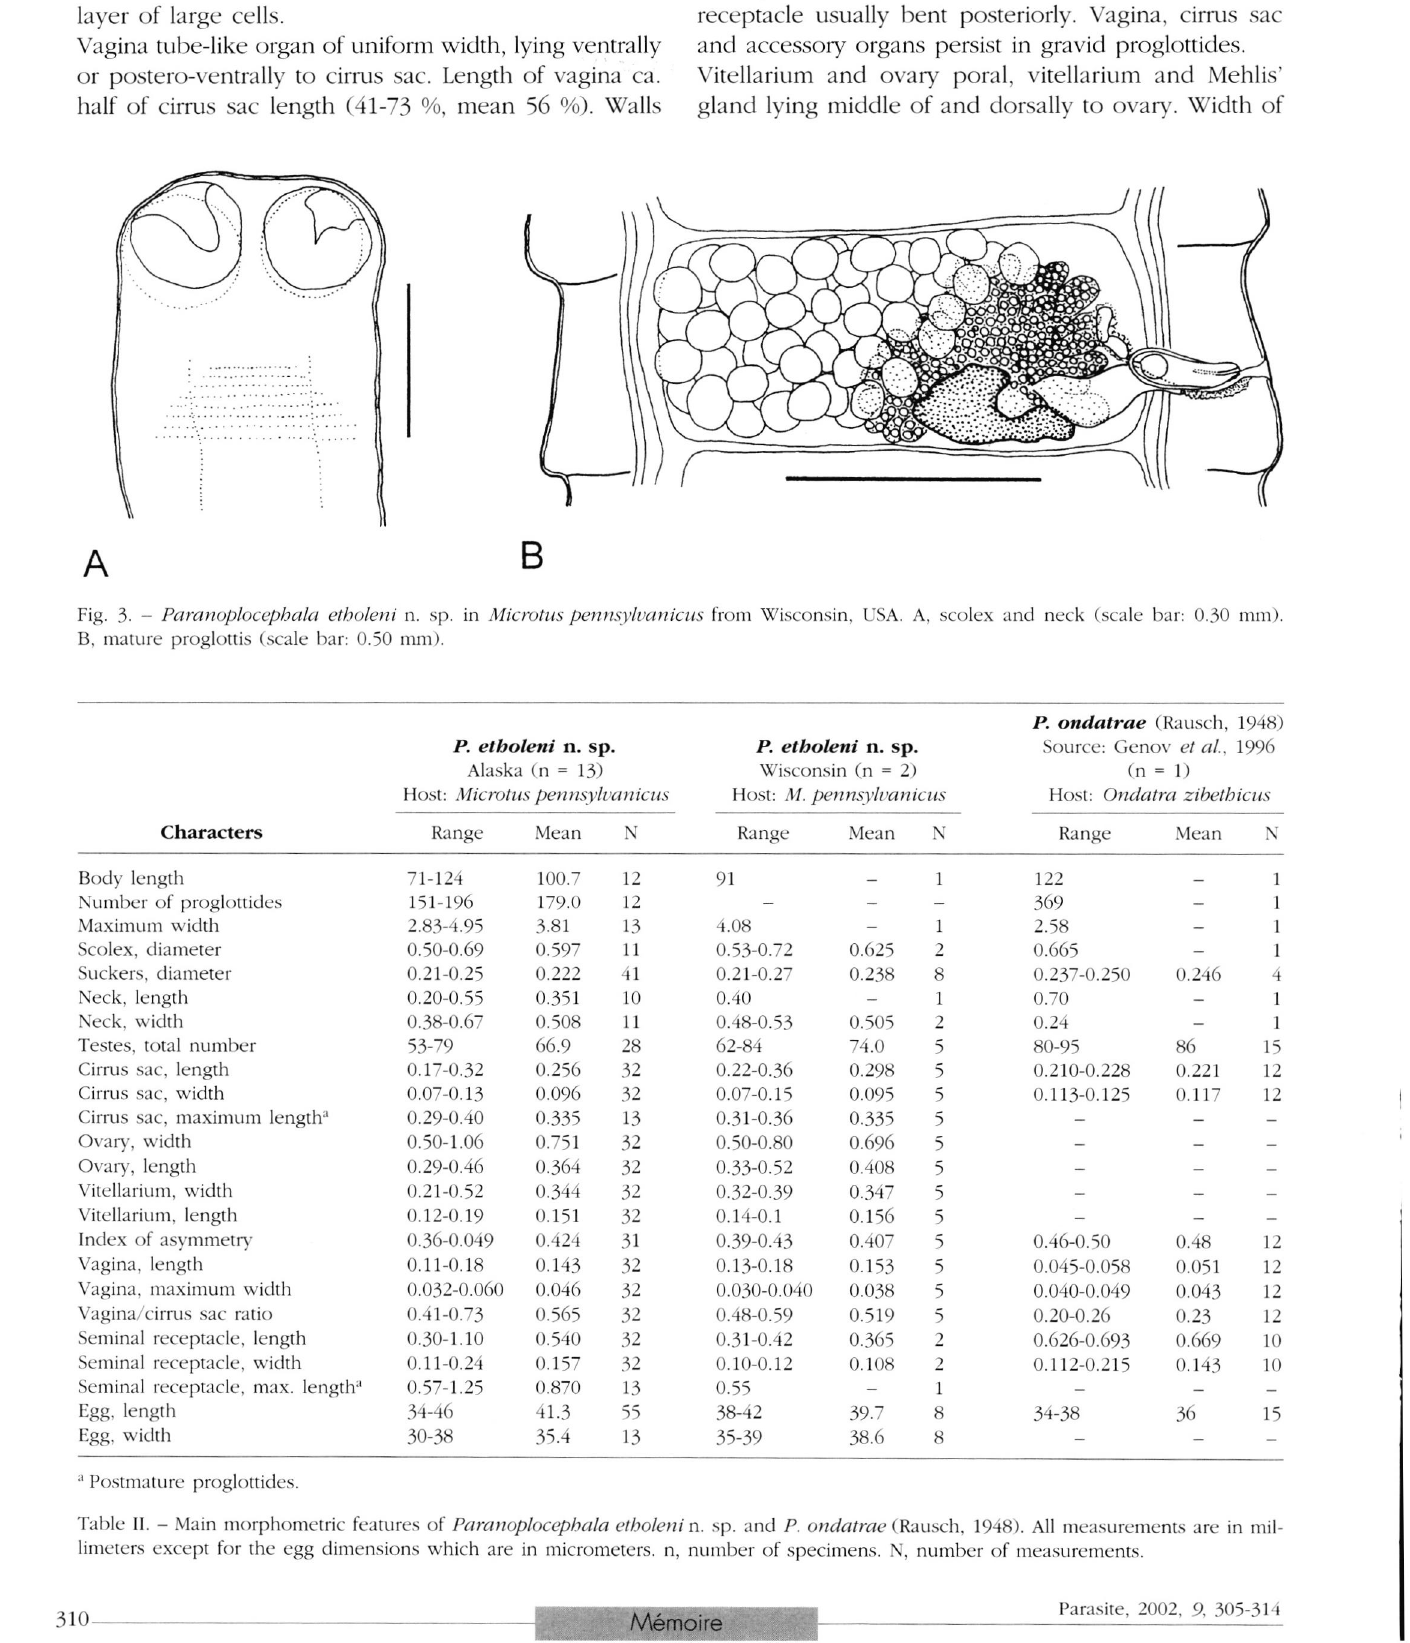
Table II. - Main morphometric features of Paranoplocepbala etholeni n. sp. and P. ondatrae (Rausch. 1948). All measurements are in mil­ limeters except for the egg dimensions which are in micrometers, n, number of specimens. N, number of measurements.